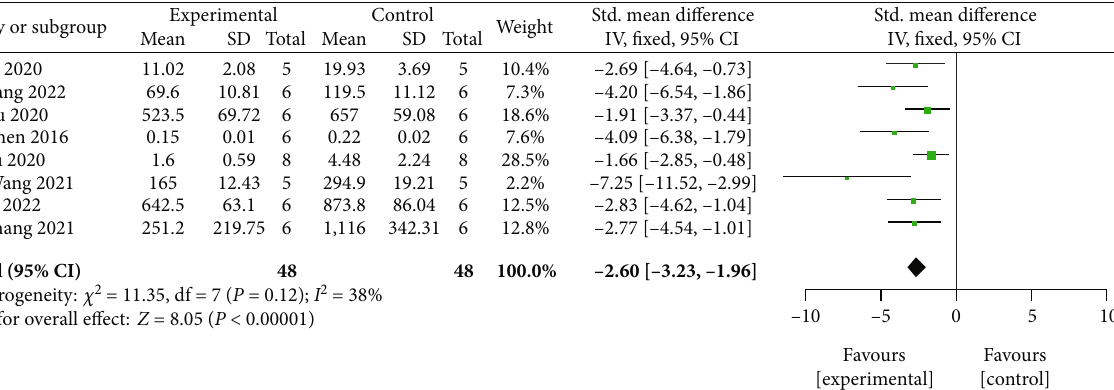
Figure 7: The forest plot: e ff ects of MSCs-derived sEVs for reduced the expression of proin fl ammatory factor TNF- α compared with control group.